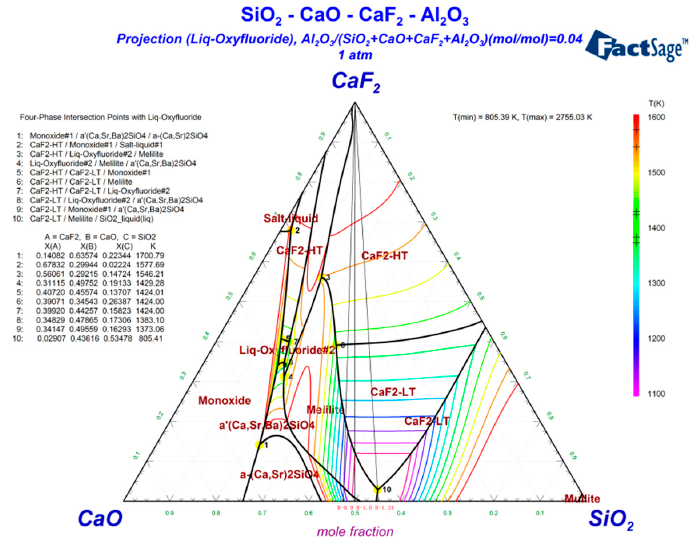
Figure 1. CaO–SiO 2 –Al 2 O 3 –CaF 2 quaternary phase diagram.